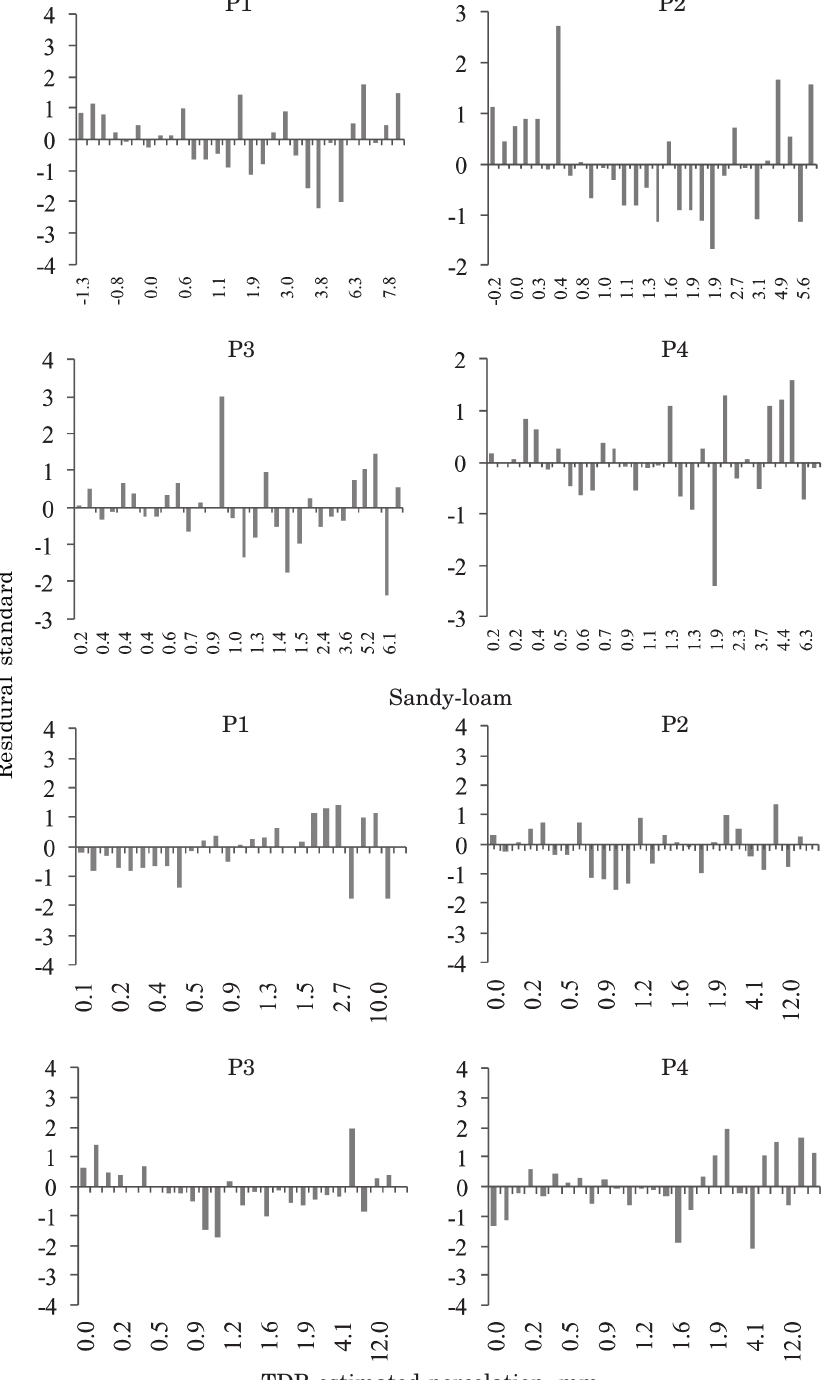
Figure 5. Residual standard errors of regression coefficients of the TDR-estimated and lysimeter-measured percolation